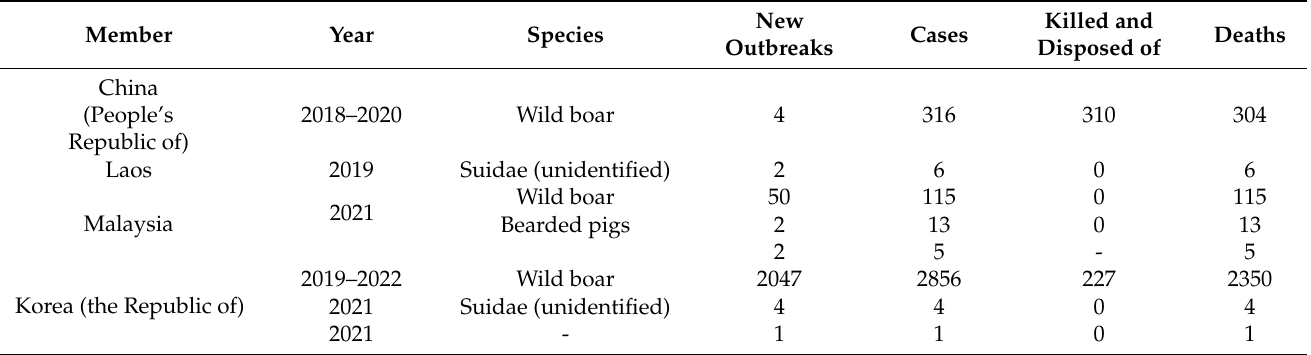
Table 3. Reports of African swine fever in World Animal Health Information System in wild suids in World Organisation for Animal Health Members of Asia and the Pacific.